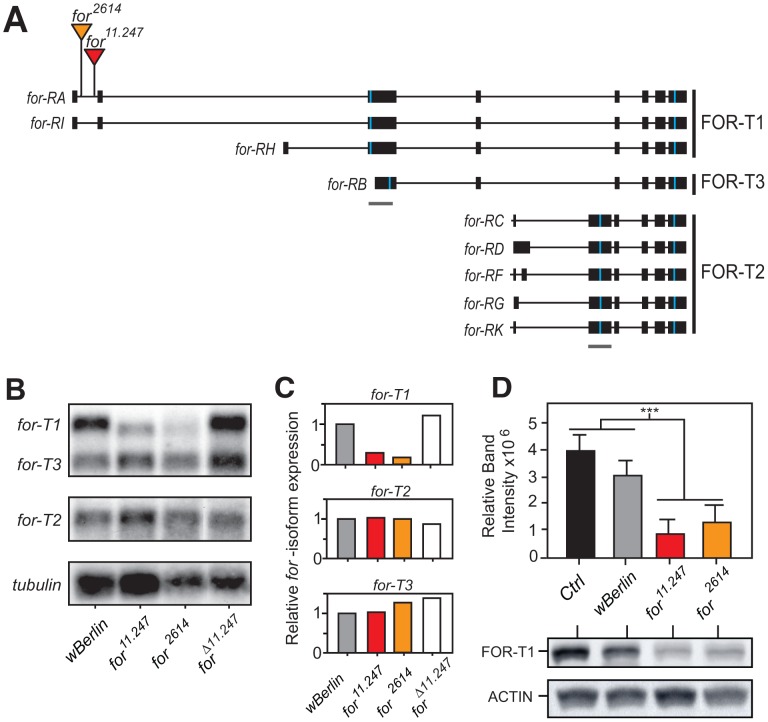
Molecular characterization of for alleles.
A) Schematic of the for transcription unit, with insertion sites of for11.247 and for2614. Blue bars represent translation start/stop sites, grey bars represent region probed for for-T1/T3 and for-T2 transcripts. The 3 major for isoforms, collectively called for-T1/T2/T3 have a total of nine splice forms, all encoding a common kinase domain at the 3′ end. FOR-T1 is a 1088 amino acid (aa) protein encoded by for-RA/RH/RI, FOR-T2 is a 894 aa protein encoded by for-RC/RD/RF/RG/RK, and FOR-T3 is a 742 aa protein encoded by for-RB. B) Northern blot of adult fly mRNA using probes specific to for-T1/T3 or for-T2 transcripts. B, top panel) In the control strain (wBerlin) we detected two bands with the for-T1/T3 probe. Based on its size, the upper, more intense, band corresponds to for-T1 transcripts, while the lower, less intense band, to the for-T3 transcript. Compared to wBerlin and forΔ11.247(a precise excision of for11.247) a reduced intensity of for-T1, but not for-T3 transcripts, was seen in for11.247 and for2614. B, middle panel) Using a for-T2 probe we detected no differences in levels of for-T2 transcripts in either for11.247 or for2614. B, bottom panel) A tubulin probe was used to compare total mRNA levels. C) Quantification of Northern Blot showing reduced for-T1, but not for-T2 or for-T3, in for11.247 and for2614. Levels were calculated as a ratio between for and tubulin band intensity. D) Quantification and representative Western blot of extracts from adult heads analyzed with an antibody that recognizes FOR-T1. Compared to controls, we saw a reduction of FOR-T1 in both for11.247 and for2614 (p<0.001; n = 3).